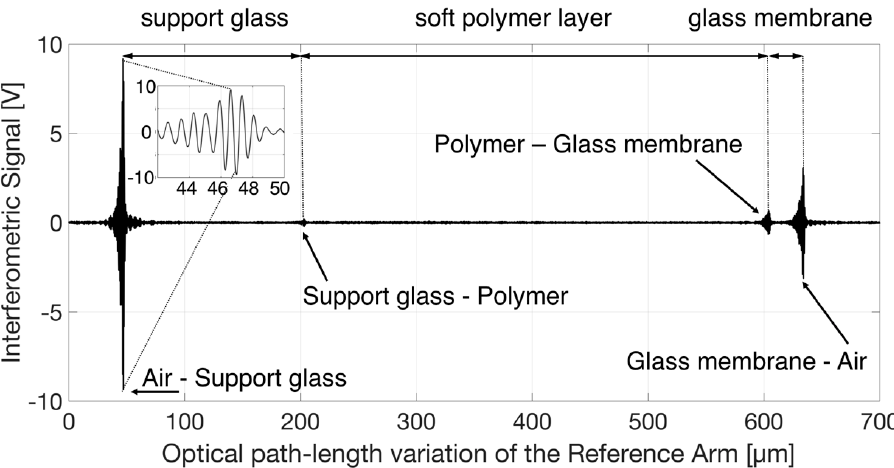
Figure 3. Interferometric signal as a function of the optical path-length variation of the Reference Arm. Four groups of amplitude modulated fringes can be recognized. Inset: zoom of the signal that shows detail of the amplitude-modulated fringes.